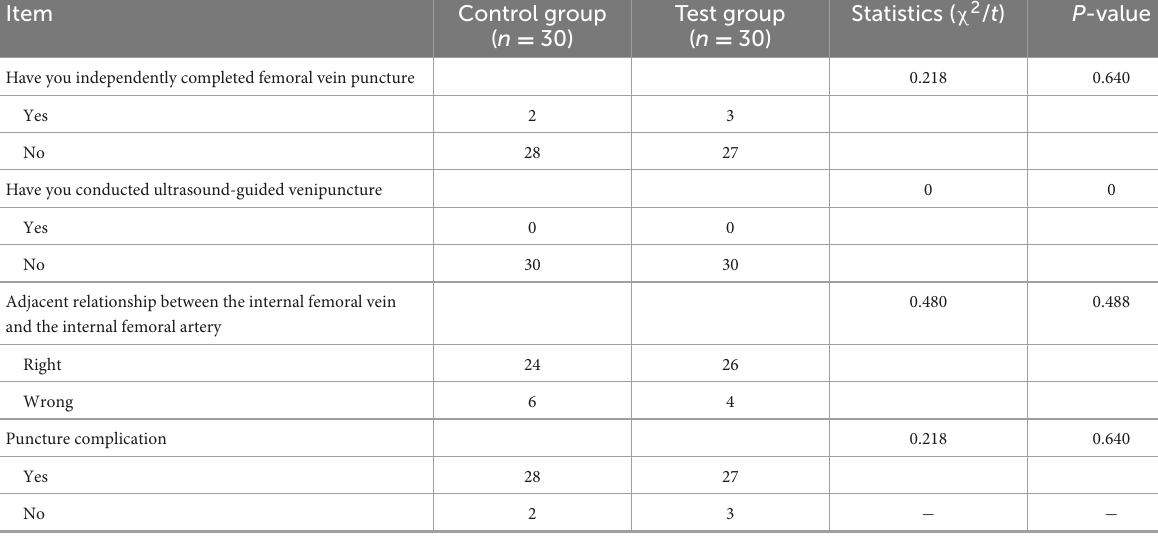
TABLE 2 Questionnaire survey results of resident doctors in two groups.